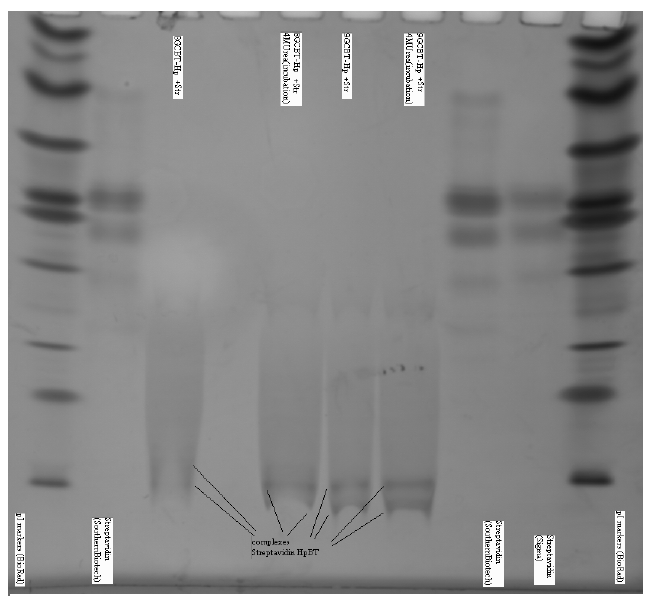
Figure 7. Complexes examined for streptavidin and biotinylated hairpins (Bt-8gc and Bt-9gc). Isoelectric focusing 3–10 pH range is implemented using a vertical system. Incubation time was 40min. Urea concentration in the sample buffer was 4 M (with no urea in the gel). Outer lanes: pI markers (BioRad). Inner lanes from left: (1) Streptavidin (Southern biotech); (2) Biotinylated 8GC hairpin + Streptavidin; (3) Biotinylated 8GC hairpin + Streptavidin + 4 M urea incubation; (4) Biotinylated 9GC hairpin + Streptavidin; (5) Biotinylated 9GC hairpin + Streptavidin + 4 M urea incubation; (6) Streptavidin (Southern biotech); and (7) Streptavidin (Sigma). The notation at the bottom of inner lanes (2–5) marks the complexes of streptavidin and the biotinylated DNA hairpins (The well pronounced pI—shift of the protein-hairpin complex is due to the presence of strong acidic moiety of DNA.).